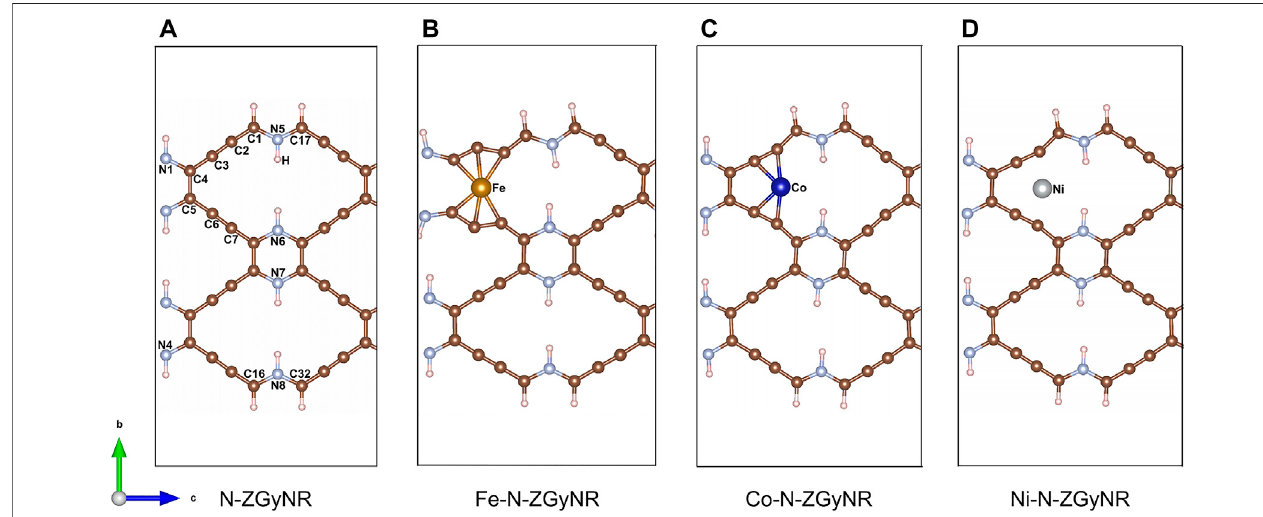
FIGURE 1 | (A – D) Structure diagram of nitrogen-containing zigzag graphynes-like nanoribbons doped with magnetic atoms (M-N-ZGyNR, M = Fe,Co,Ni). The edge C atom is passivated by a single H atom and the repetitive unit cell structure of M-N-ZGyNR has been marked by the gray imaginary rectangle region.